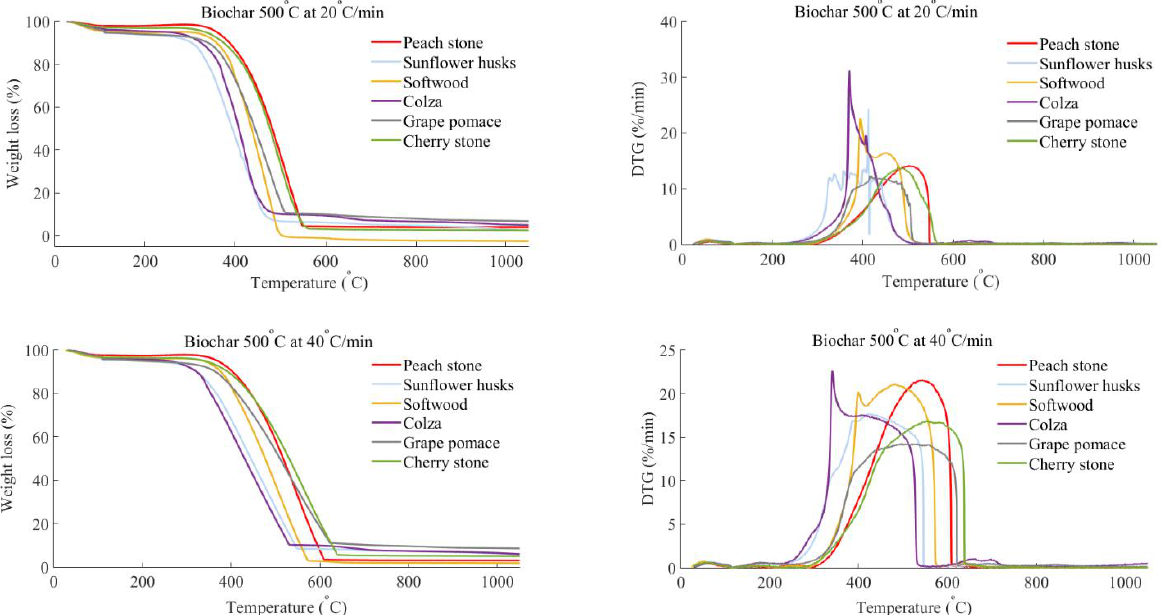
Figure 2. Effect of feedstock on the oxidation of six types of biochar at given heating rate (20 and 40 °C/min), TGA and DTG in air.